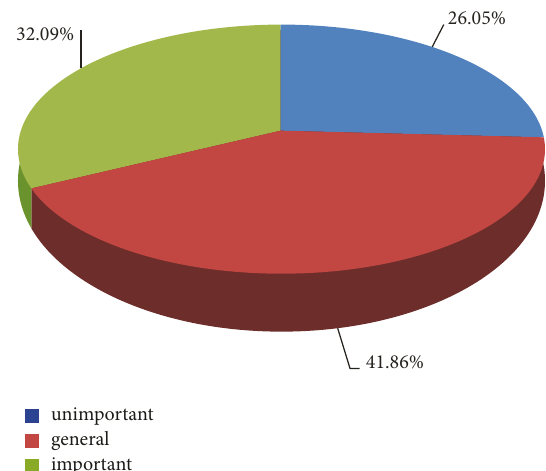
Figure 8: Distribution of survey respondents’ attitudes towards the importance of garbage classification.